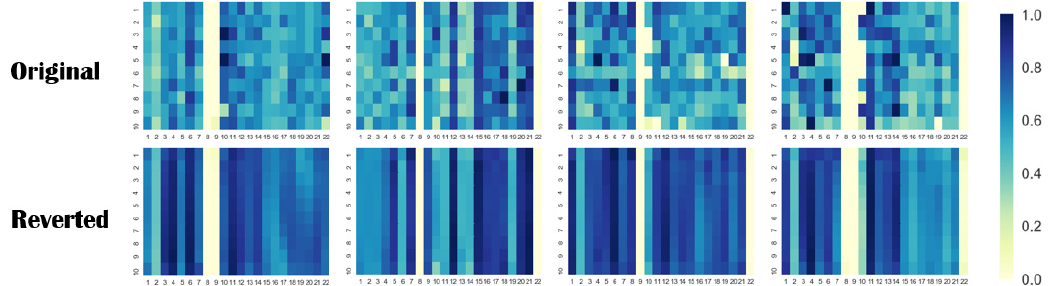
Figure 2. The effect of DCAE treatment on the yogurt sensory heatmap. Figure 2. The e ff ect of DCAE treatment on the yogurt sensory